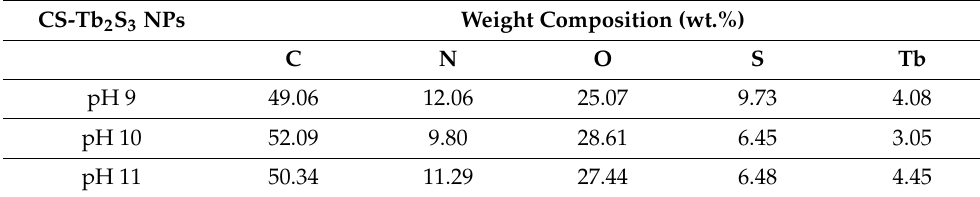
Table 3. Elemental composition (wt.%) for CS-Tb 2 S 3 NPs based on SEM-EDX